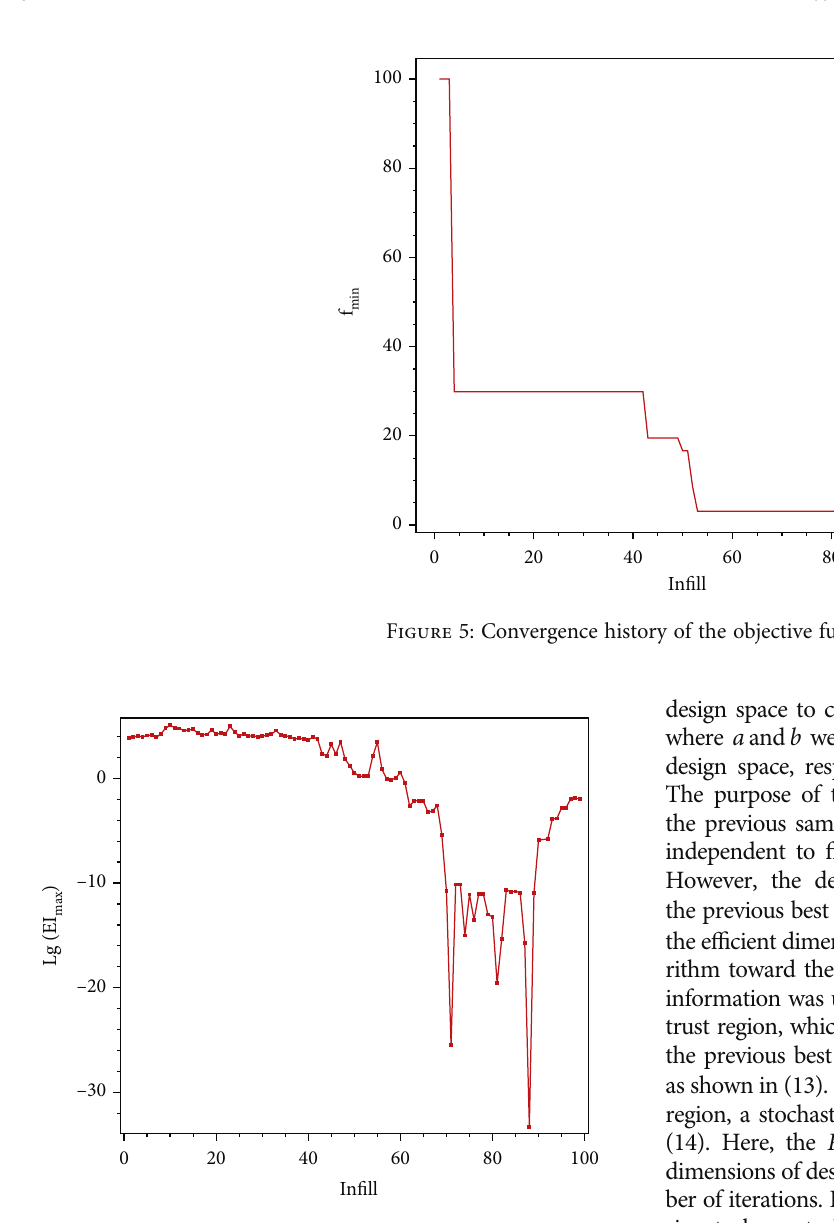
Figure 6: Convergence history of max